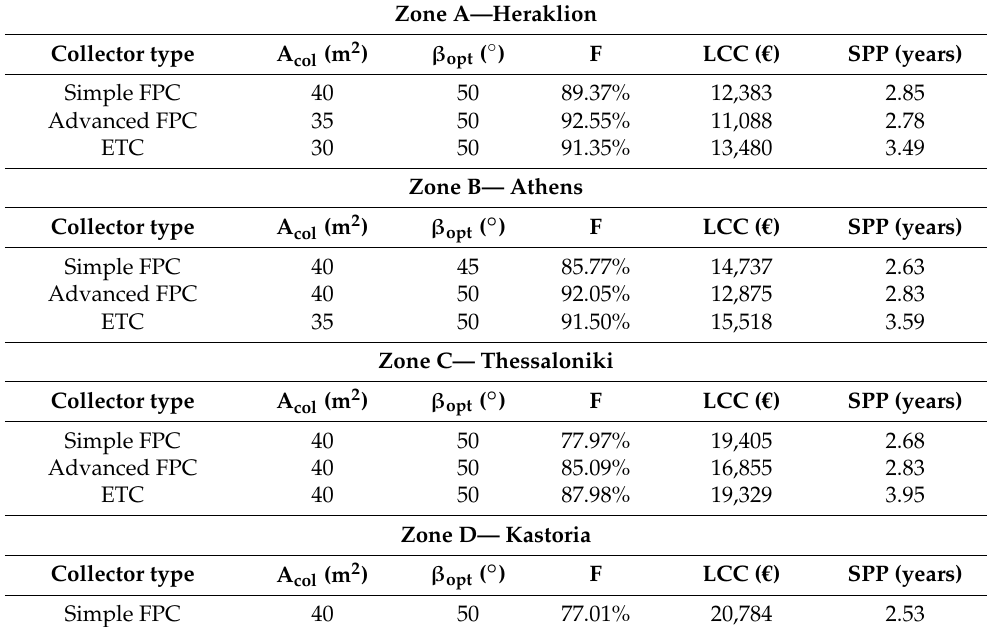
Table 7. Summary of the optimum designs according to the maximization of the life cycle cost index.